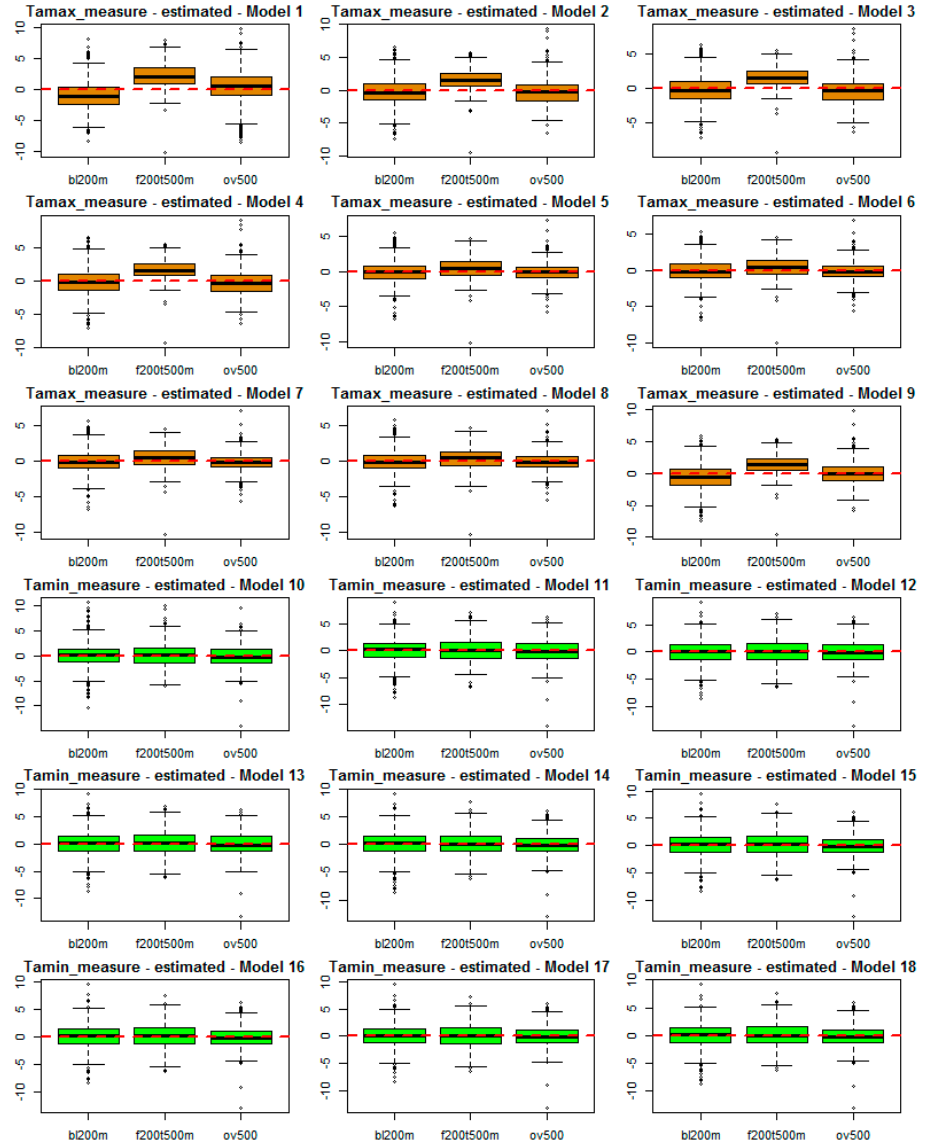
Figure 9. Box-plots with the difference between T a -estimated and T a -measured by the elevation of the station (Ele). The line within the box indicates the median. The bottom of the box is the first quartile, and the top is the third quartile. Whiskers represent the lowest value still within 1.5 IQR (IQR = third quartile − first quartile) and the highest value still within 1.5 IQR. The black plus mark indicates outliers. bl200m (Ele < 200 m), f200t500 (200 m ≤ Ele ≤ 500 m), ov500 (Ele > 500 m).